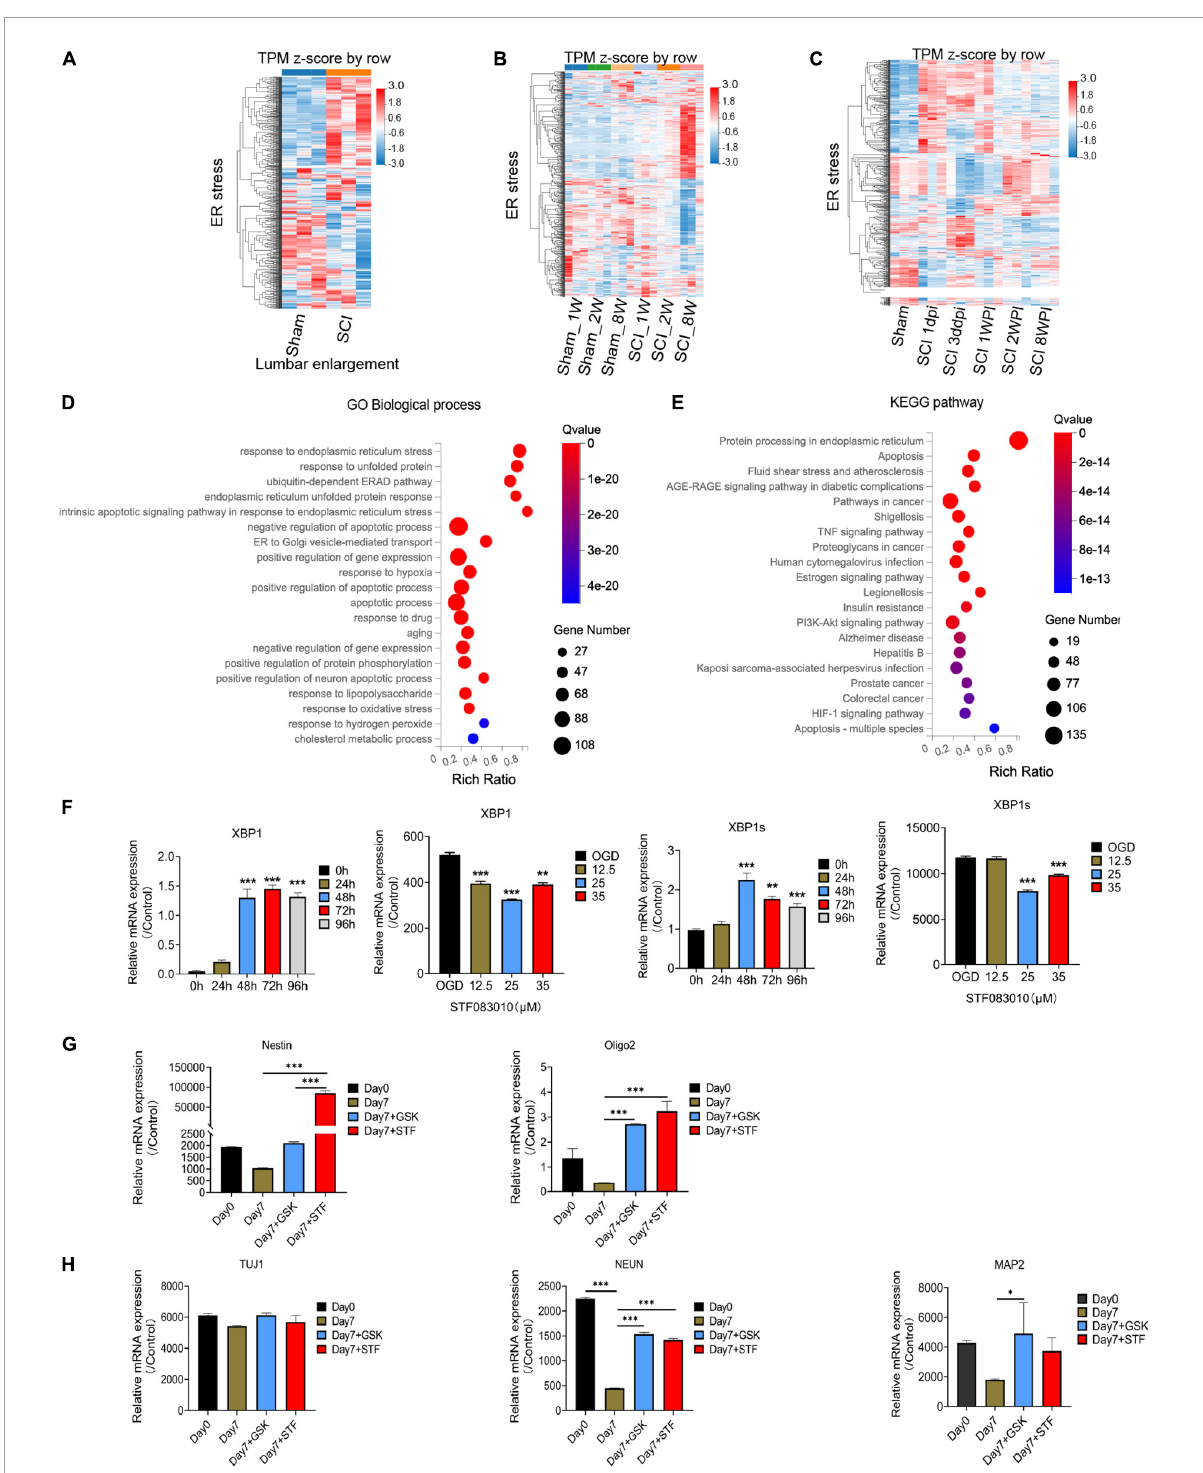
FIGURE7 RNA-seq and bioinformatics analysis results after spinal cord injury (SCI) and RT-PCR results. (A–C) Heatmaps showed that the transcripts of ER stress related genes were significantly up-regulated after SCI. Dpi, day post-injury; WPI, week post-injury; Sham _1w, Sham _1 week age; Sham_2w, Sham _2 weeks age; Sham _8w, Sham_8 weeks age; SCI_1W, SCI_1 week age; SCI_2W, SCI_2 weeks age; SCI_8W, SCI_8 weeks age. (D,E) GO and KEGG pathway analysis also revealed that ER stress associated signaling pathways were significantly activated. (F–H) The RT-PCR results of Xbp1 and Xbp1s (spliced Xbp1), Nestin, Oligo2, Tuj1, NEUN, and MAP2 mRNA expression. n = 3 biological repeats. Values are the mean ± SEM. Statistical significance was determined by one-way ANOVA followed by Student Newman–Keuls post-hoc test. ∗ P < 0.05, ∗∗ P < 0.01, ∗∗∗ P <